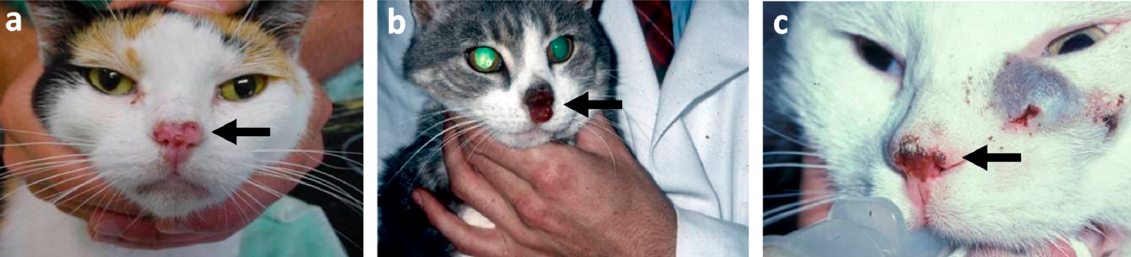
Figure 4. Three cases of cutaneous squamous cell carcinoma (SCC) on the nasal planum of cats. ( a ) Macroscopic image of an early cutaneous SCC in an 8-year old female Tortisehell cat. ( b ) Macro- scopic image of a proliferative cutaneous SCC in a 10-year old male Tabby cat. ( c ) Macroscopic image of a cutaneous SCC in a 10-year old female cat (of unknown breed). The arrows point to the SCC lesion on each cat. It is interesting to note that all areas affected have white hair coat. Photos courtesy of Dr. Richard Malik (The University of Sydney).